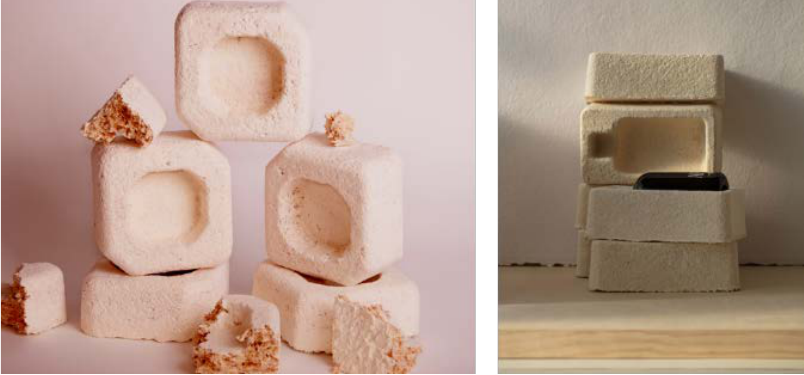
Figure 4 Ecovative Design LLC. Packaging Products